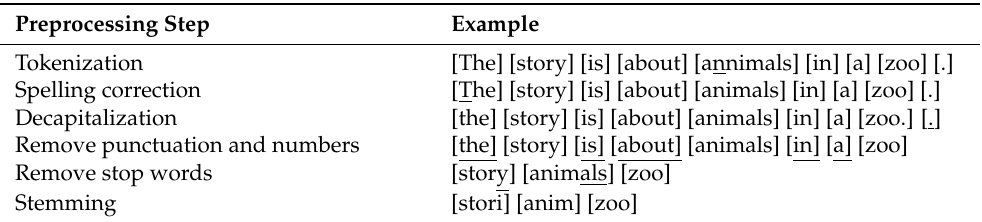
Table 1. Demonstration of the preprocessing pipeline based on the misspelled sample response, ‘The story is about annimals (sic!) in a